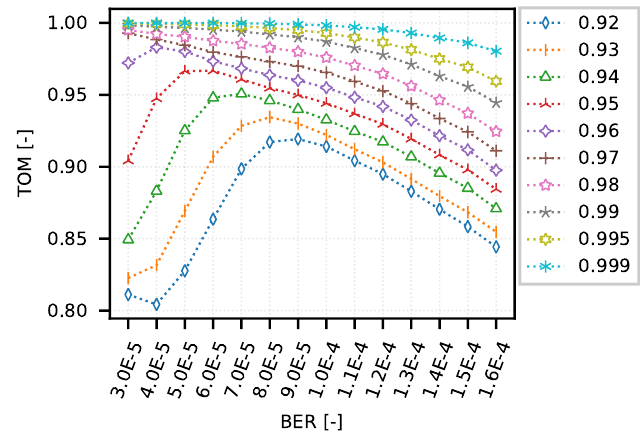
Figure 7. DumbBell—example of optimization curves (mean quantiles 0.92–0.999 of BER 9 × 10 − 5